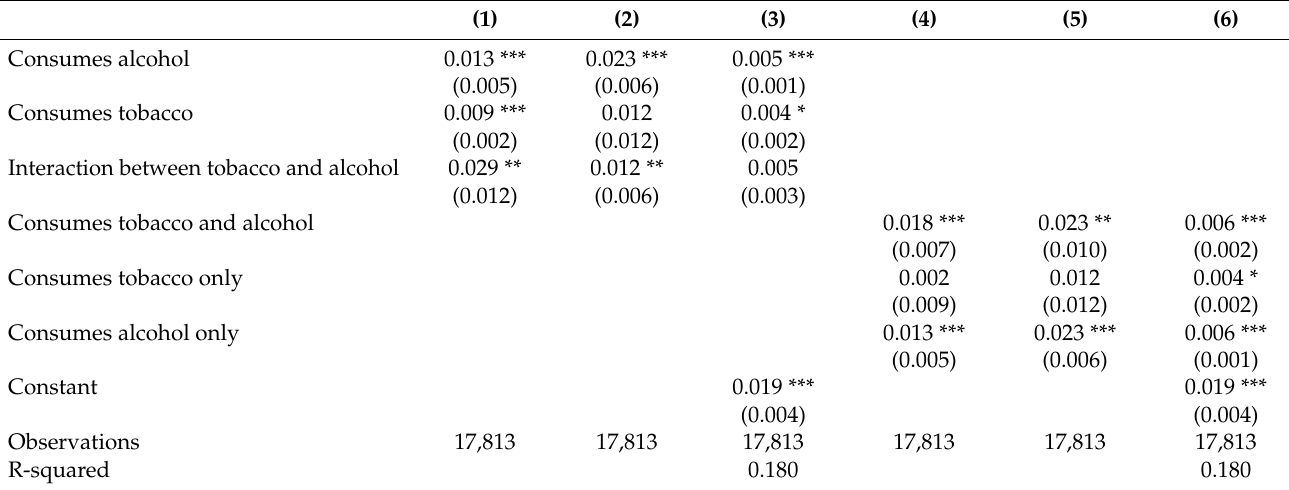
Table 4. Regression estimates for tobacco/alcohol-related health